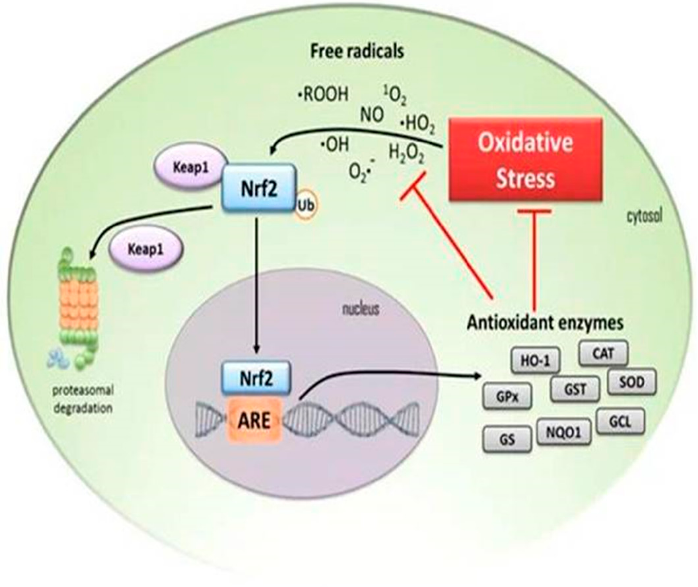
Figure 3. The activation of Nrf2-inducing antioxidant genes. Under a homeostatic state, cytosolic Nrf2 is maintained at reduced levels by proteasomal degradation induced by the Keap1 protein complex.